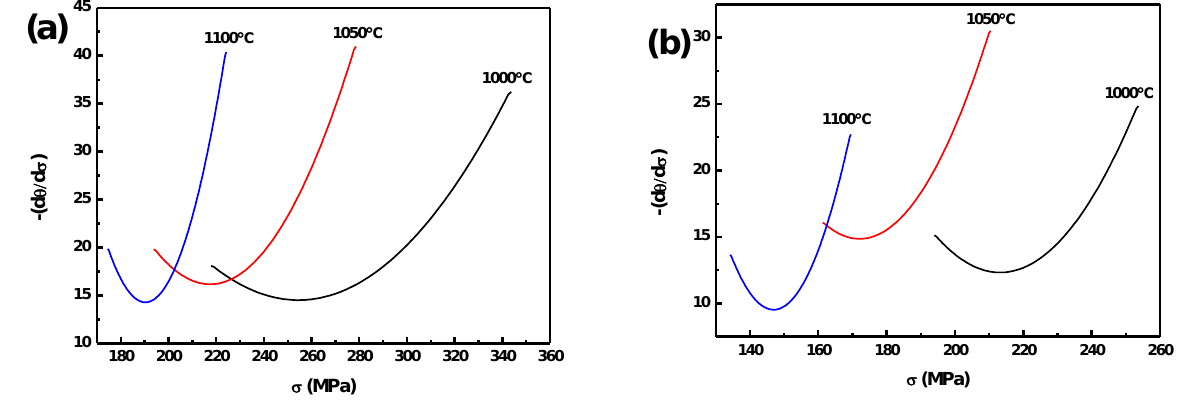
Figure 6. Curve of –(d θ /d σ )- σ at three temperatures, under two strain rates ( a ) 10 s −1 and ( b ) 1s −1 . Table 2. Peak stress, peak strain, critical stress and strain for 304B7 BSS and related steels. The obtained values for peak stress, peak strain, critical stress and strain are summa-